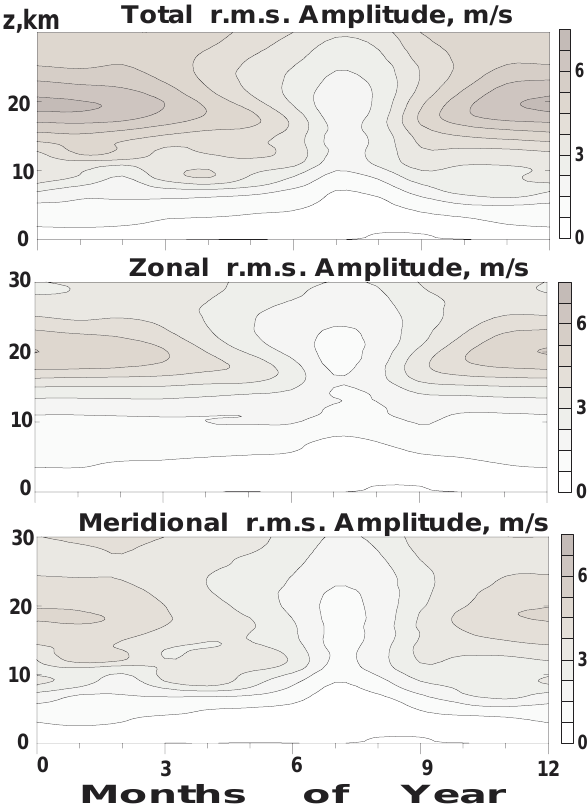
Fig. 5. Calculated seasonal distributions of total (top), zonal (mid- dle) and meridional (bottom) wind standard deviations produced by IGW